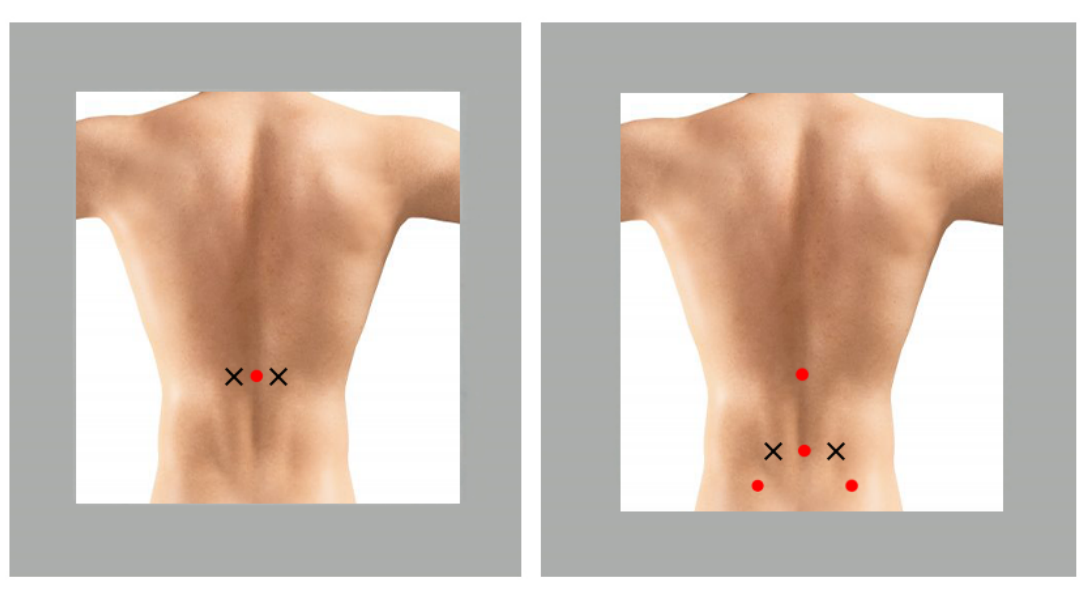
Figure 2. Application points of the electrodes, following the European recommendations [33]. The cross indicates the application points, while the dots indicate the